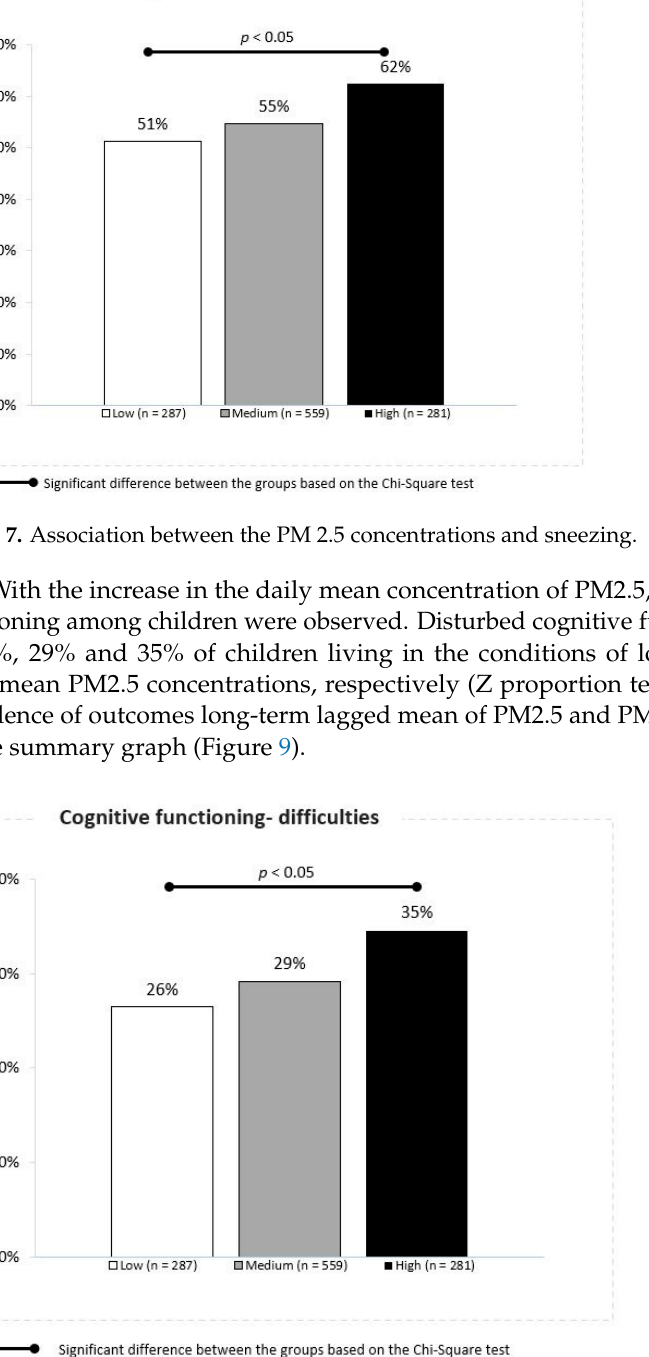
Figure 8. Association between the PM 2.5 concentrations and disturbed cognitive functioning. Other URTS considered in our study i.e., sore throat, hoarseness, loss of appetite, headache, fatigue, irritability, nervousness, difficulty in thinking, redness of the eyes, a sensation of sand under the eyelids, eye discomfort, vision problems, ear pain and feeling of ear clogging showed no significant association with increased PM10 or PM2.5